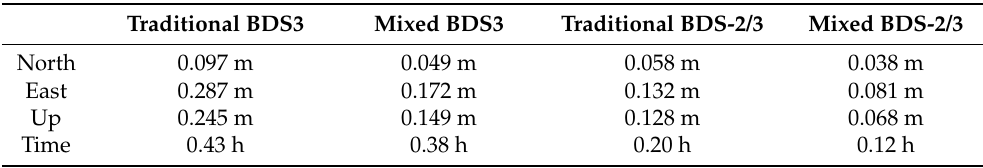
Figure 10. Mixed multi-frequency vs. traditional multi-frequency UDUC PPP positioning errors. Table 6. The positioning errors in the E, N, and U directions and the convergence times of traditional multi-frequency and mixed multi-frequency UDUC